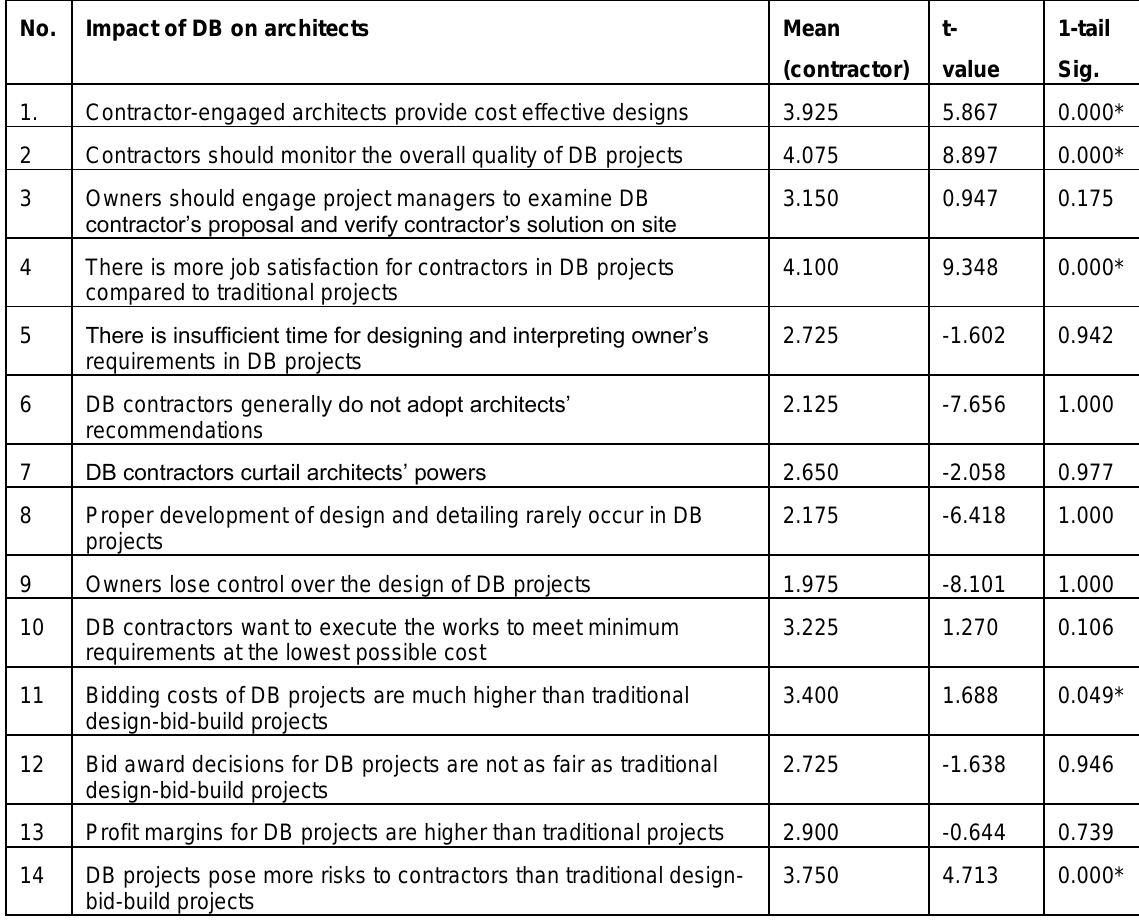
Table 3 : Survey results on impact of DB on contractors